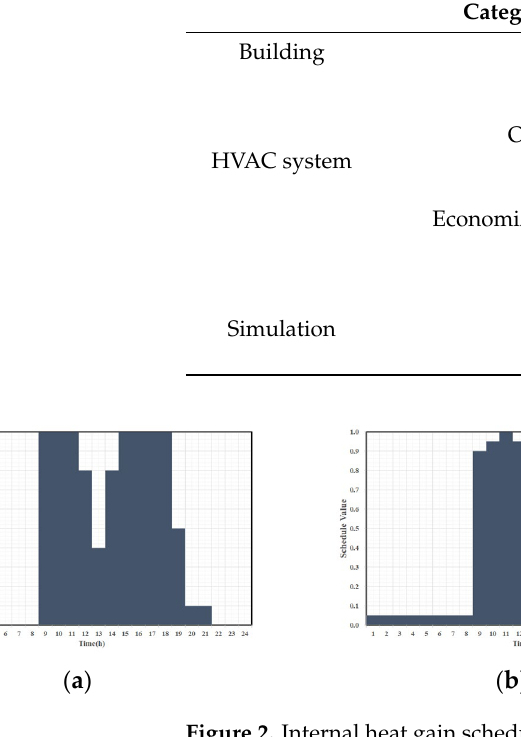
Figure 3. System diagram . 4.2. Co-Simulation This study constructed a co-simulator using EnergyPlus, Matlab, and BCVTB. Table 4 shows the data exchanged between EnergyPlus and Matlab. The outside air tempera- ture, outdoor-air intake ratio, and supply air fraction were transmitted from EnergyPlus to Matlab, and the set value of the mixed-air temperature was transmitted from Matlab to EnergyPlus. Figure 4 shows the integrated control system using BCVTB.